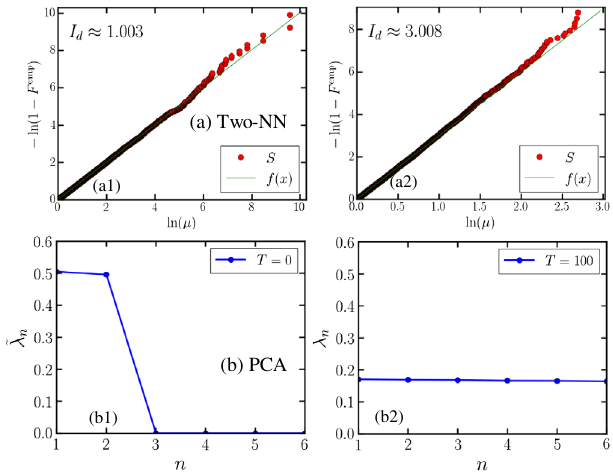
FIG. 10. Three-site XY model. Panels (a1) and (a2) show results of the two-NN method: fitting of the data points S for (a1) T ¼ 0 and (a2) T ¼ 100 . The data set has N 10 3 configura- r ¼ tions. We obtain (a1) I d ¼ 1 and (a2) I d ¼ 3 . Panels (b1) and (b2) show results of the PCA method: normalized eigenvalues of the ˜ λ XY configurations. covariance matrix, n , obtained from the raw Here, we use the same notation as Ref. [27]. For n > I PCA d , ˜ λ → 0 . PCA predicts (b1) I PCA 2 and (b2) I PCA 6 , which is n d ¼ d ¼ not in agreement with the exact results (see text).